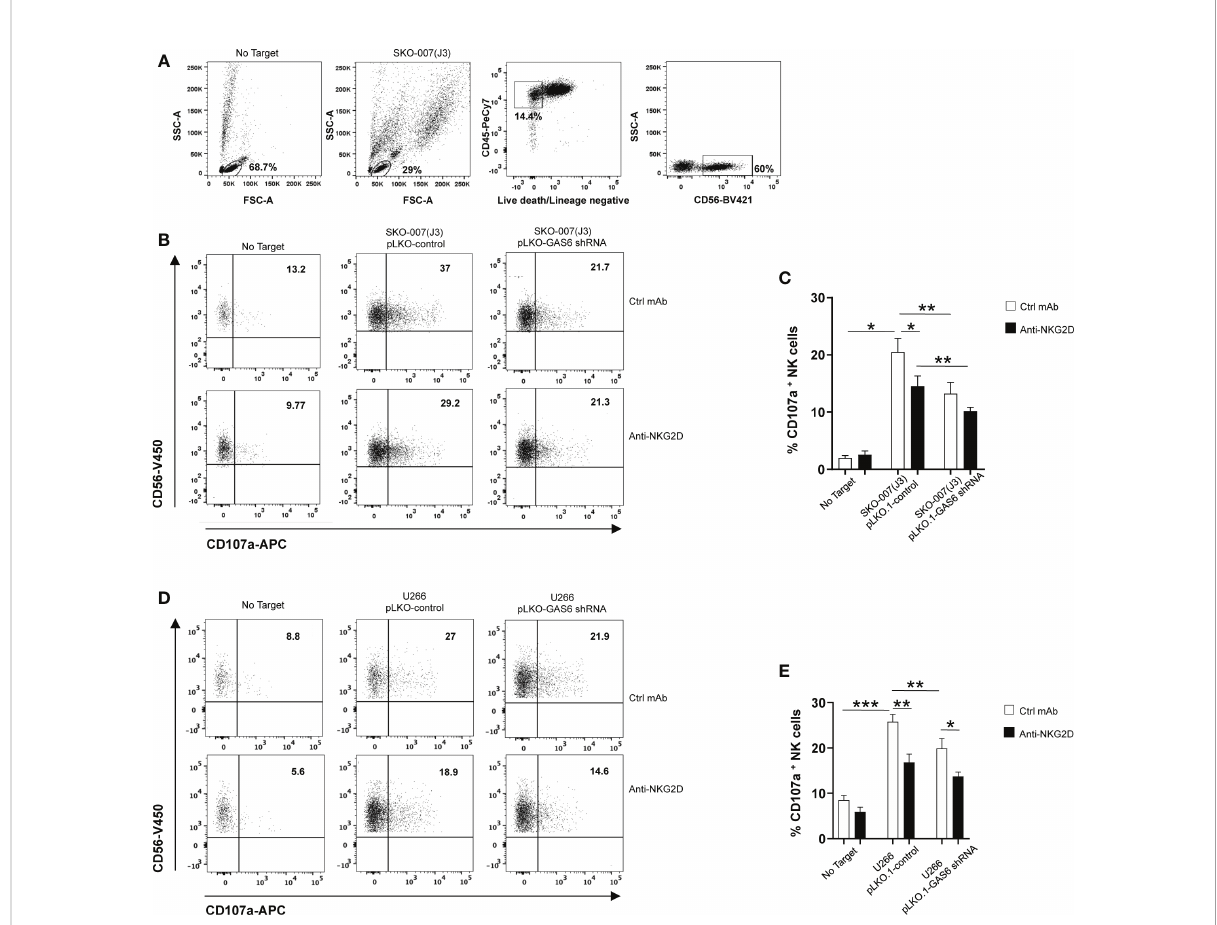
FIGURE 2 Impaired NKG2D-dependent recognition of GAS6-depleted MM cells. Healthy donor-derived PBMCs were incubated with SKO-007(J3) (A – C) or U266 (D, E) pLKO.1-GAS6 shRNA or pLKO.1-Control at E/T ratio of 1:1. CD107a expression was analyzed on CD3 - CD19 - CD14 - CD45 + CD56 + NK cells as shown in (A, B) . To evaluate the role of NKG2D, the assay was performed in parallel treating NK cells with blocking anti-NKG2D or anti-IgG mAb used as control (Ctrl). Results are expressed as the percentage of CD107a + NK cells. A representative experiment for each MM cell line is shown in (B, D) . Histogram represents the mean ± SD from three independent experiments (C, E) (*p < 0.05; **p < 0.001 ; *** p < 0.005